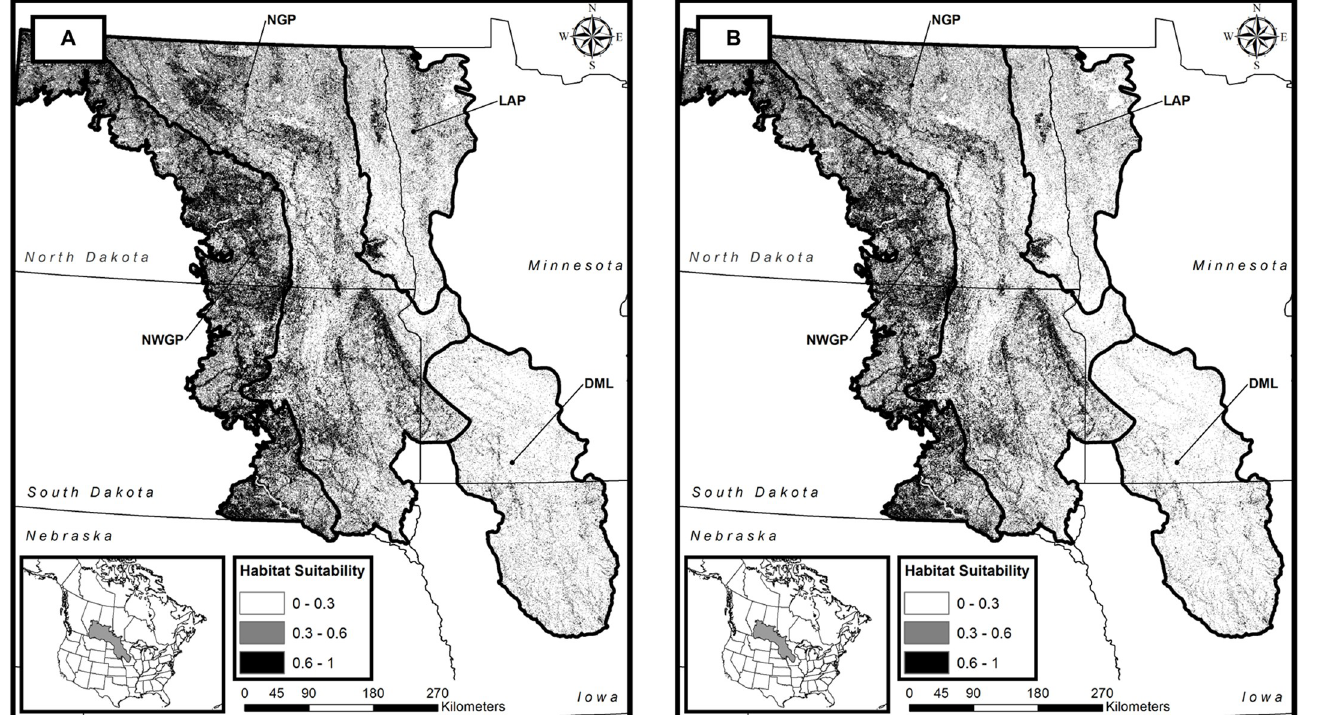
Fig 3. Distribution of suitable habitat with an InVEST habitat-quality ranking � 0.3 under a scenario in which all Conservation Reserve Program (CRP) grasslands present in the Prairie Pothole Region of the United States in 2014 are intact (Map A) and a scenario in which all CRP grasslands are converted to row-crop production (Map